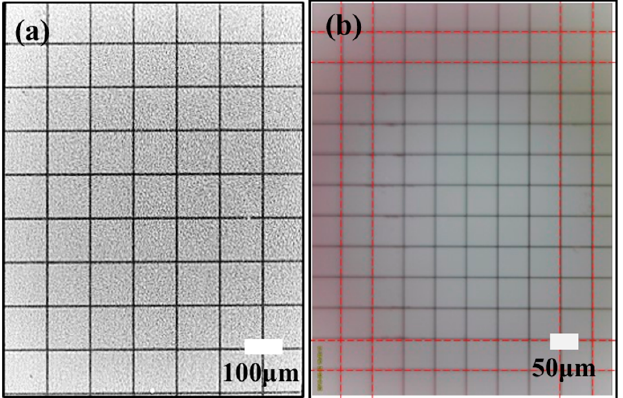
Figure 1. The FOA microscope and its imaging performance. ( a ) Photographs of the FOA microscope and schematic diagram (inset). ( b ) The related resolution and yeast cell test, while the inset is the image captured by using the commercial digital microscope. ( c ) The yeast cell detection and the corresponding commercial microscope (inset figure, Keyence).